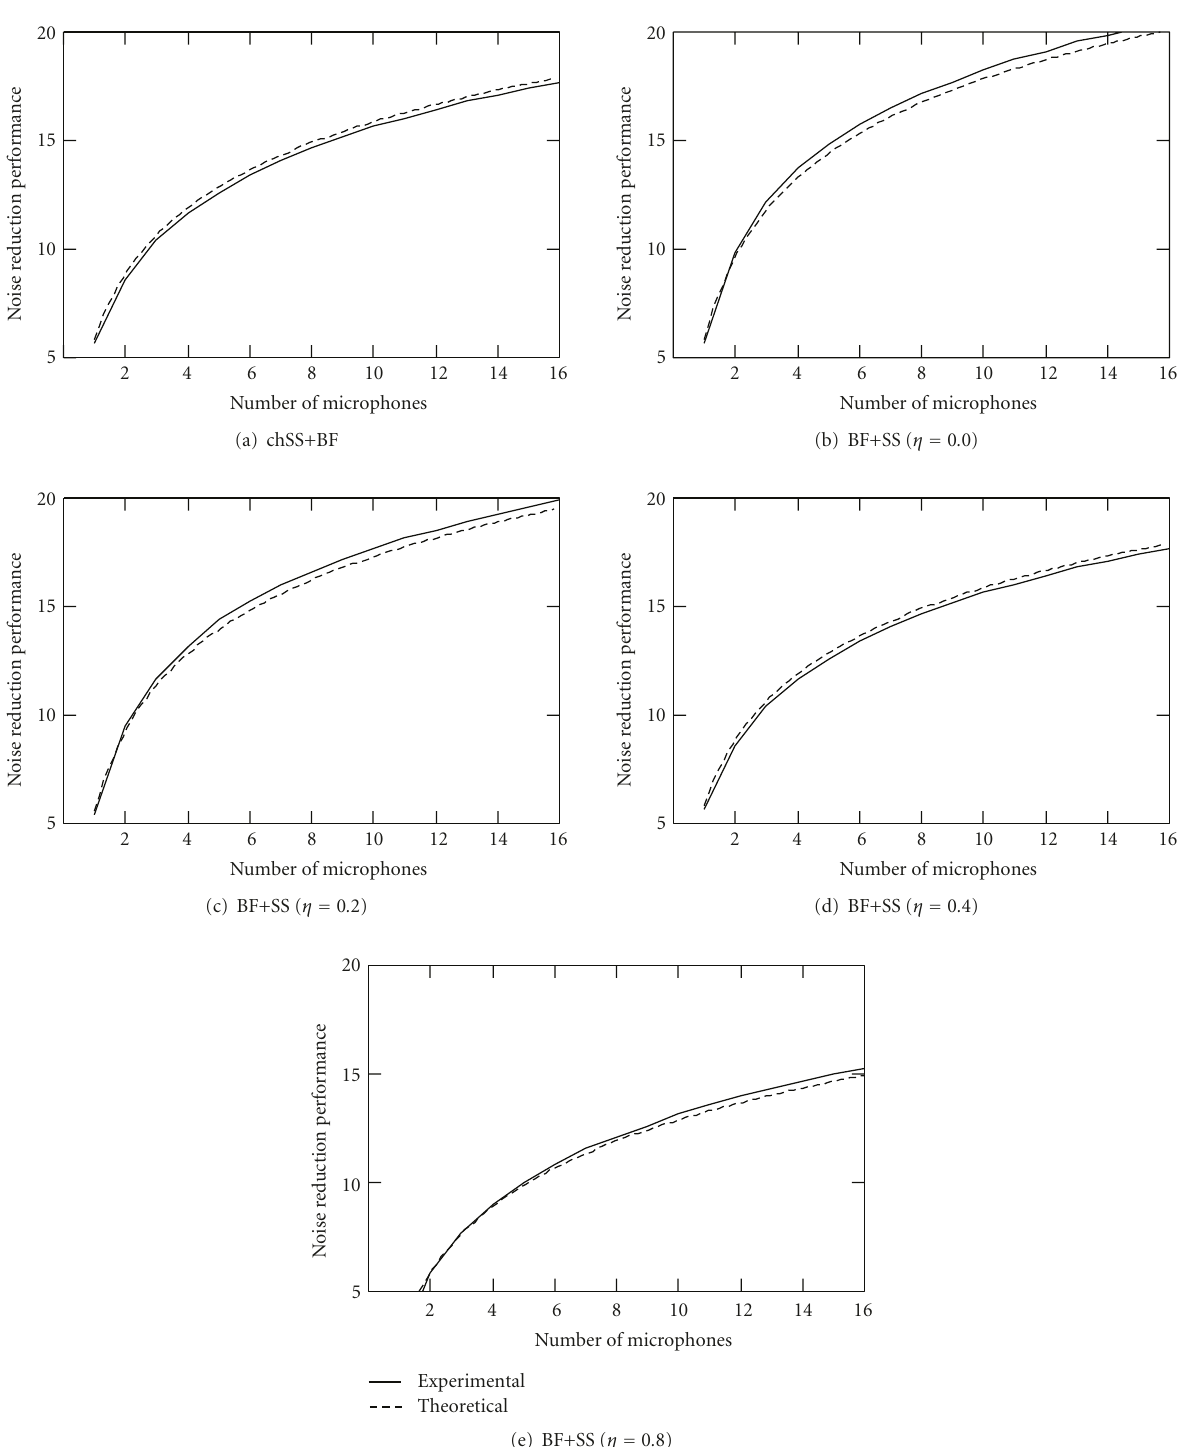
Figure 20: Comparison between experimental and theoretical noise reduction performances for super-Gaussian input signal.